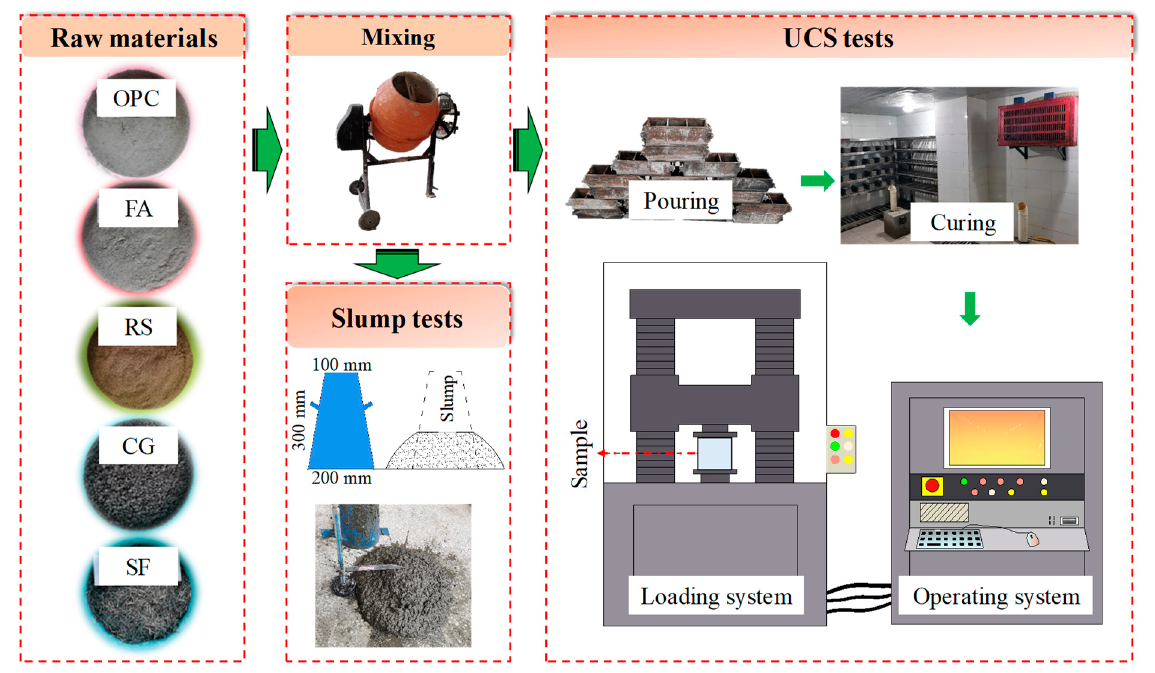
Figure 3. The experimental procedure.